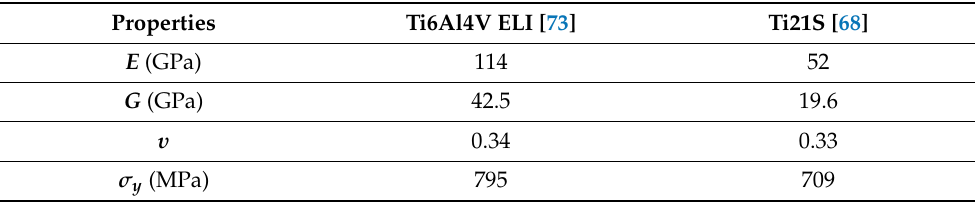
Table 2. Mechanical properties of the stem material.